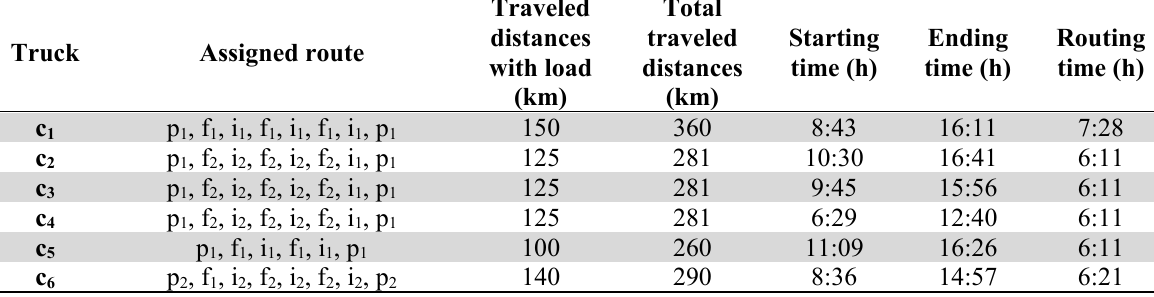
Traveled distances